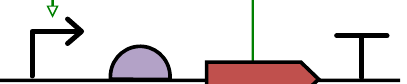
Figure 39: Promoter stimulated by the CDS that it regulates.